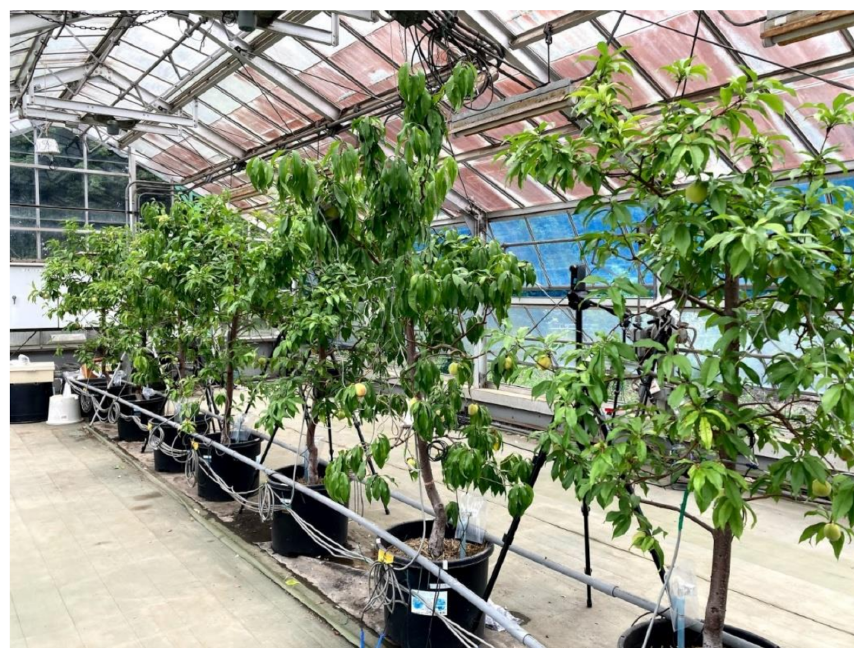
Figure 1. The planted peach tree cultivation system.